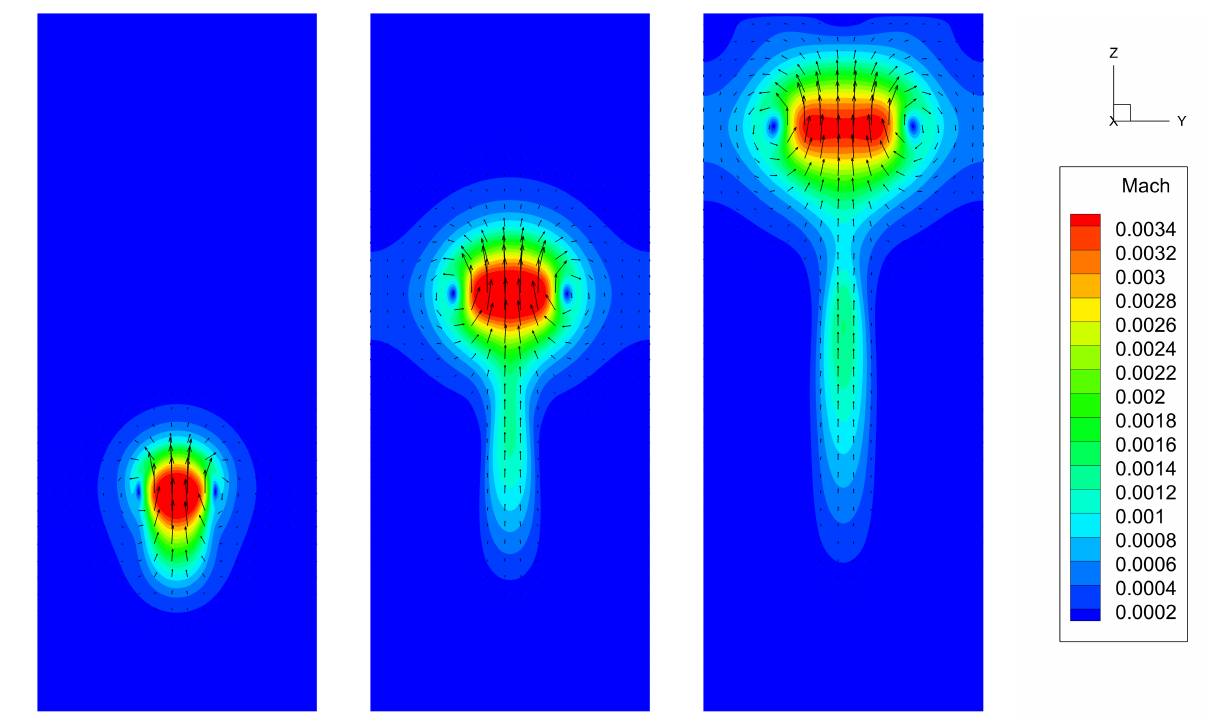
Figure 17. Mach contours and velocity vectors at plane x = 0 for the 3D rising bubble. From left to right : t = 1, t = 3, t =